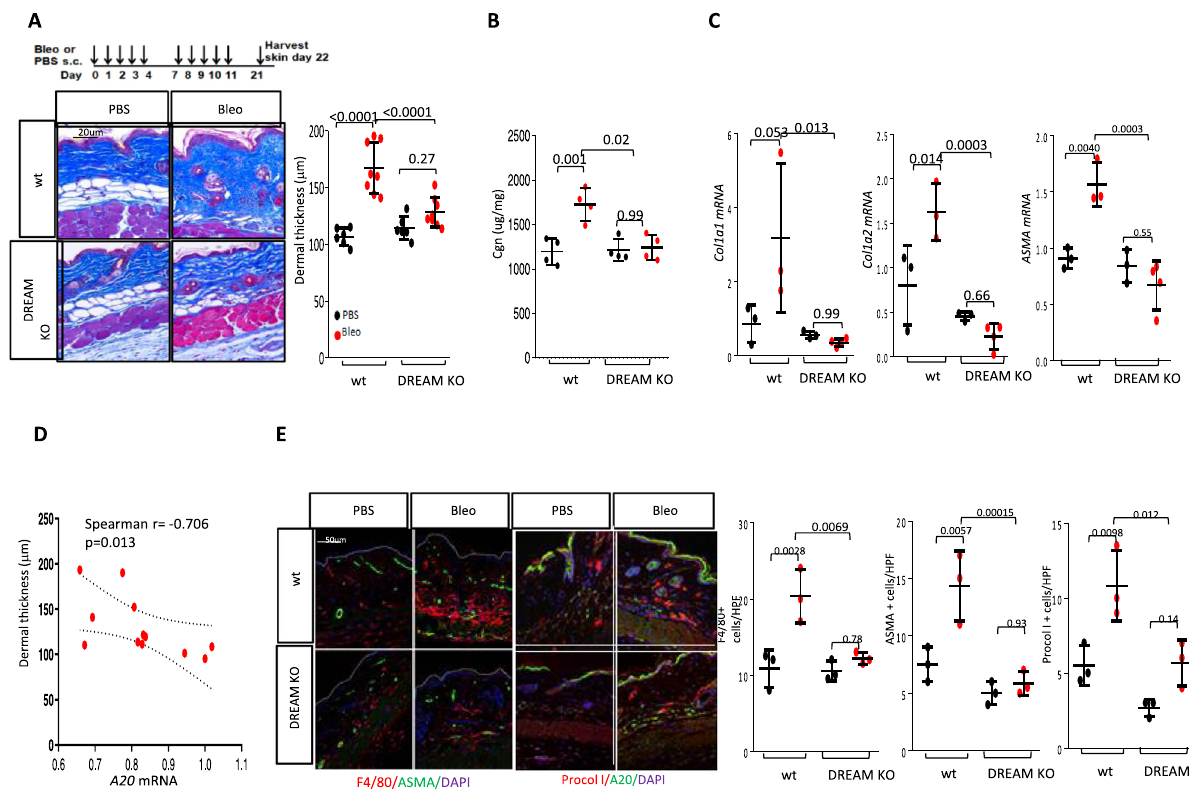
Fig. 6 | Dream -/- mice showed attenuated skin fi brosis. Eight-week-old C57/BL6 wild-typemice and DREAM -/- micewere treated inparallelwith dailys.c.bleomycin (10mg/kg/d) or PBS for 2 weeks, and lesional skin was harvested on day 22 for analysis. A Top: schematic of the experiment. Left panels: trichrome stain, repre- sentative images. Scale bar: 20 μ m. Right panel: dermal thickness (mean±SD of 5 determinations/hpf, PBS-treated, n =6, Bleo-treated, n =8). B Collagen content. One-way ANOVA followed by Sidak ’ s multiple comparison test. C qPCR. Results, normalized with GAPDH, are mean±SD of triplicate determinations from 3 mice